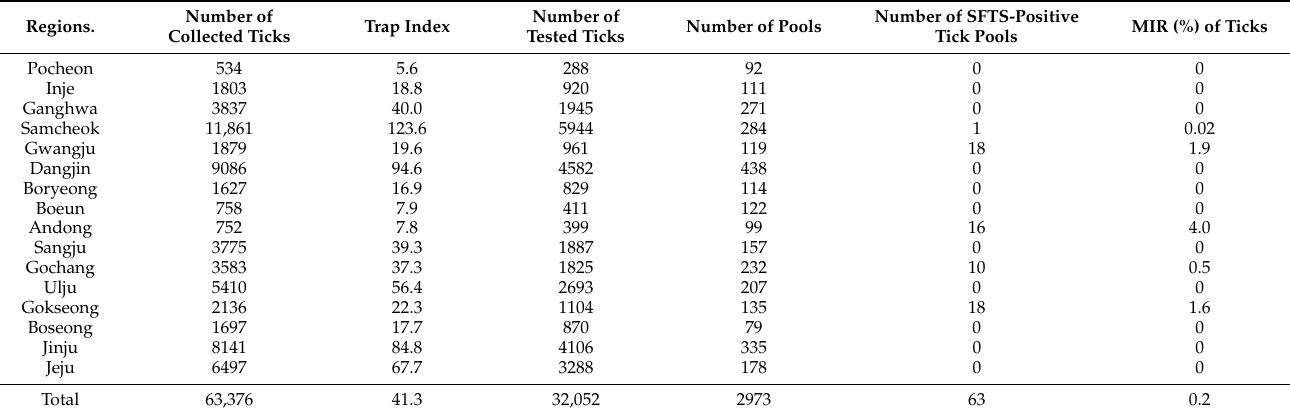
Table 3. SFTSV infection in ticks in various regions in Korea in